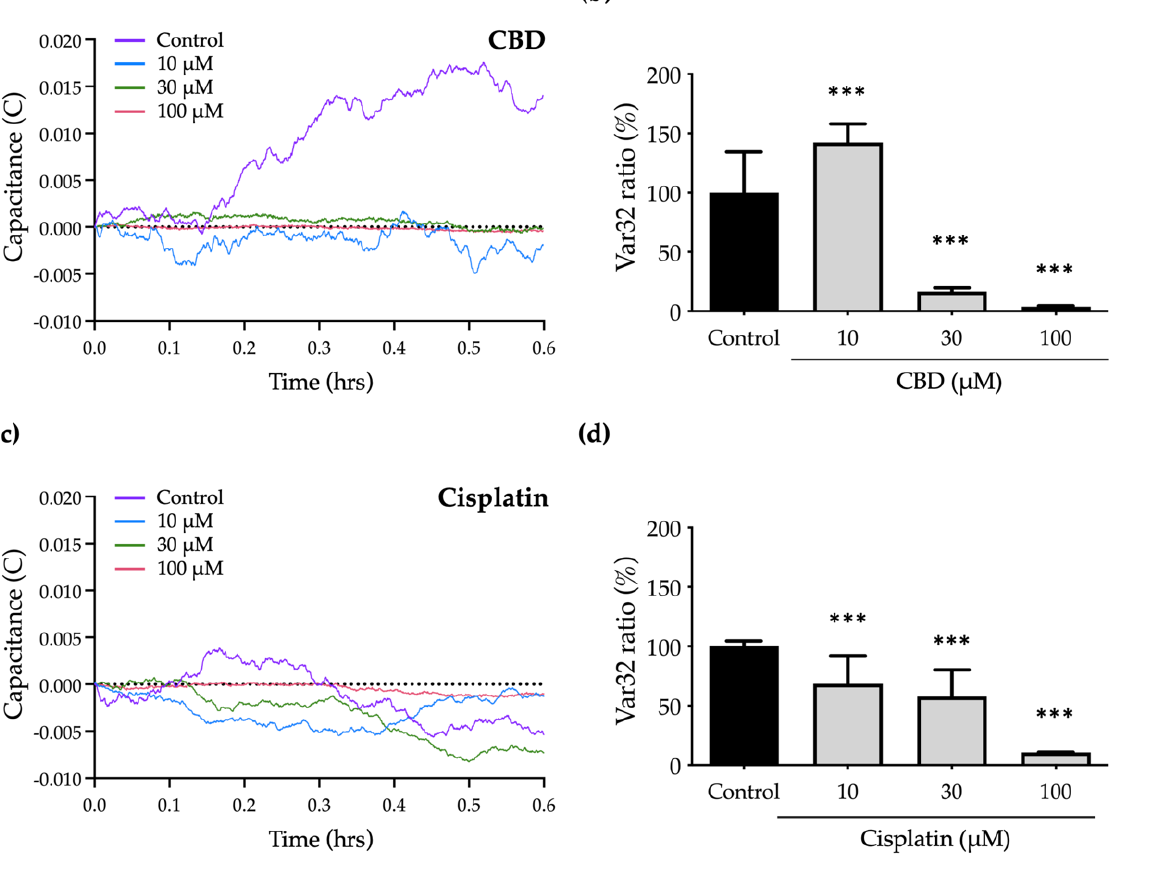
Figure 6. Effect of CBD and cisplatin on the micromotion of OEC-M1 cells: ( a ) The fluctuation in the capacitance (C) value time course shows the micromotion of OEC-M1 cells after treatment with ( a ) CBD and ( c ) cisplatin for 24 h. The C values are normalized and analyzed using the Var32 calcula- tion model, and the average cell micromotion is the Var32 ratio. The histogram shows the changes in the Var32 ratio for OEC-M1 cells that are treated with ( b ) CBD and ( d ) cisplatin at 10, 30, and 100 μM. All data are represented as mean ± standard error mean (SEM) for at least three independent experiments. *** p < 0.001 as compared with control group.